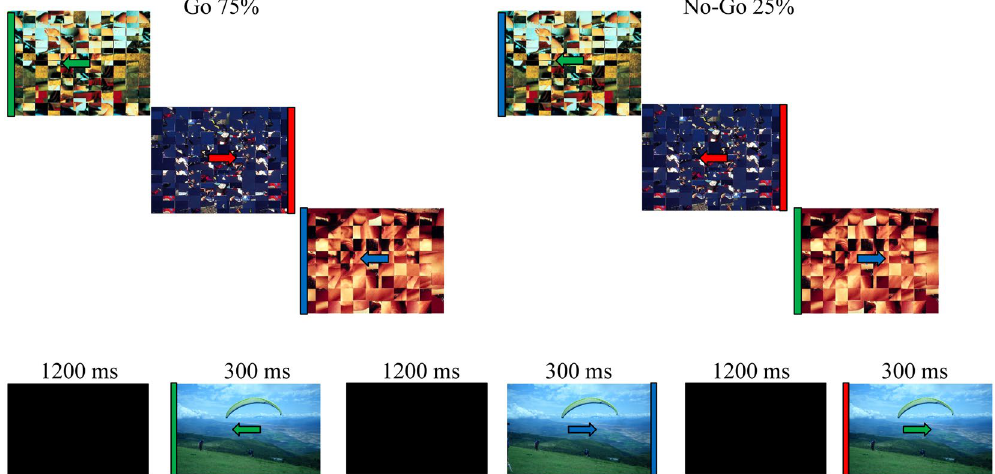
Figure 3. The Go/NoGo task paradigm. On the Go trials, the arrow and bar coincided in both direction and color, while on the NoGo trials they did not match. In the upper panel the arrow and bar are inserted in the neutral background context; in the lower panel the paradigm is represented with an example of a pleasant emotional stimulus.